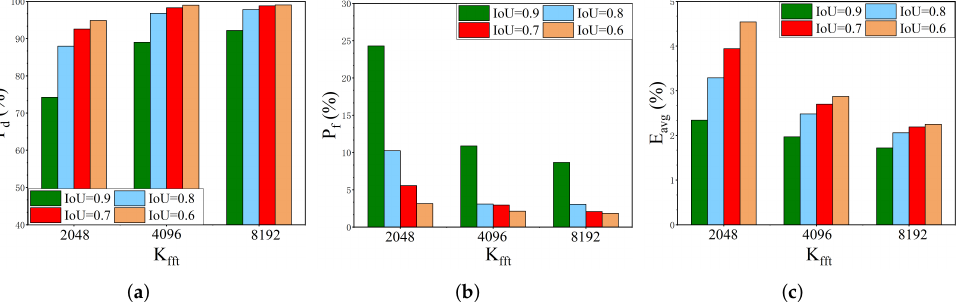
Figure 12. Performance results on the competition dataset. ( a ) detection probability; ( b ) false alarm probability; ( c ) mean absolute error of parameter estimation.